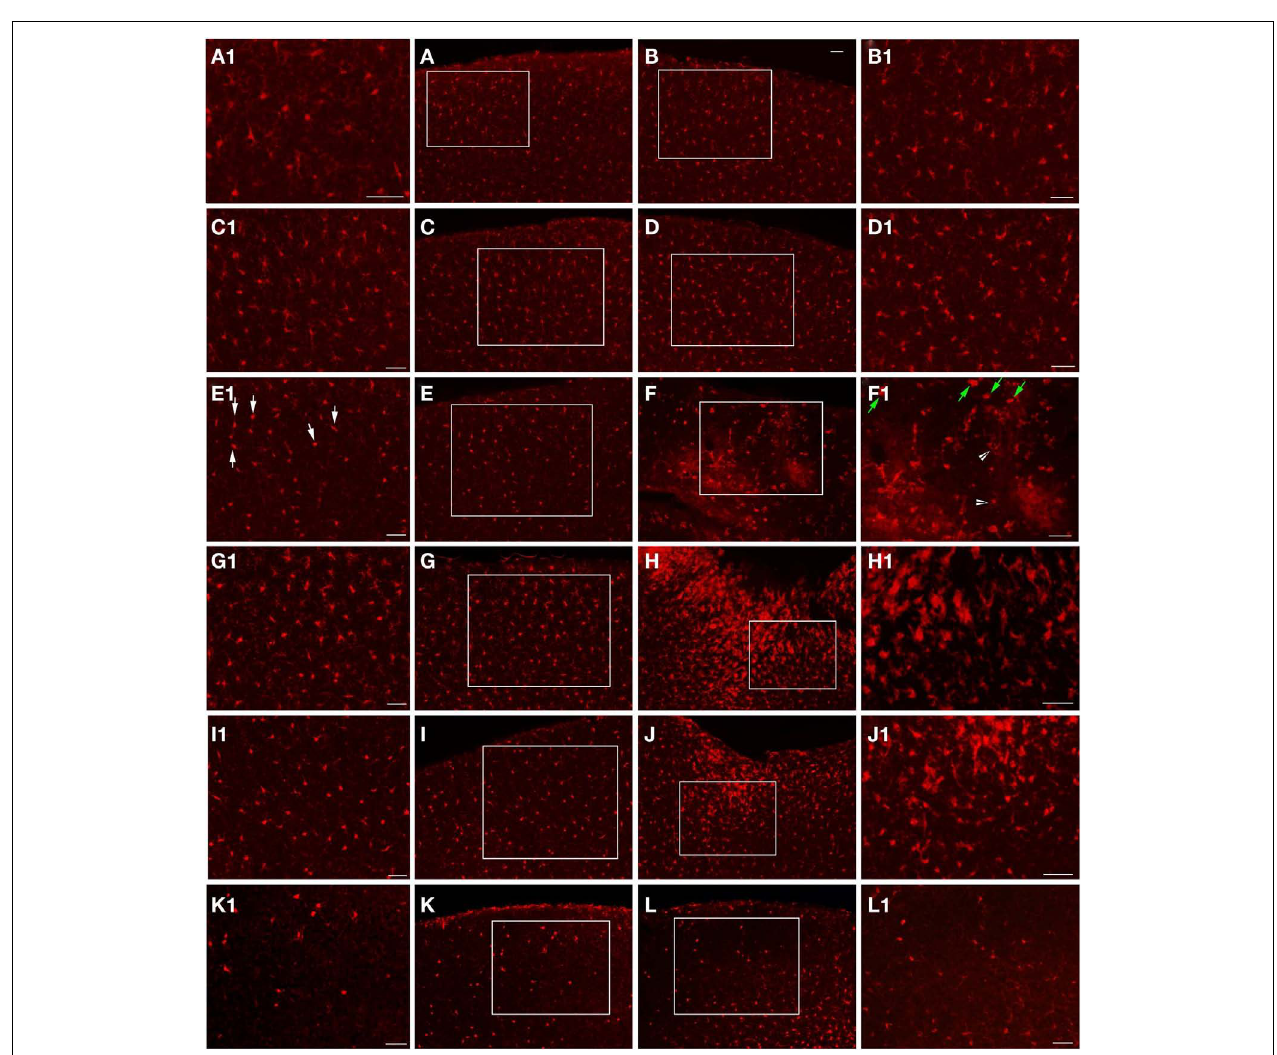
post-FPI (G,H) , microglial activation is increased in the contralateral hemisphere (G) relative to 1-day post-FPI. In the peri-lesion region (H) ,